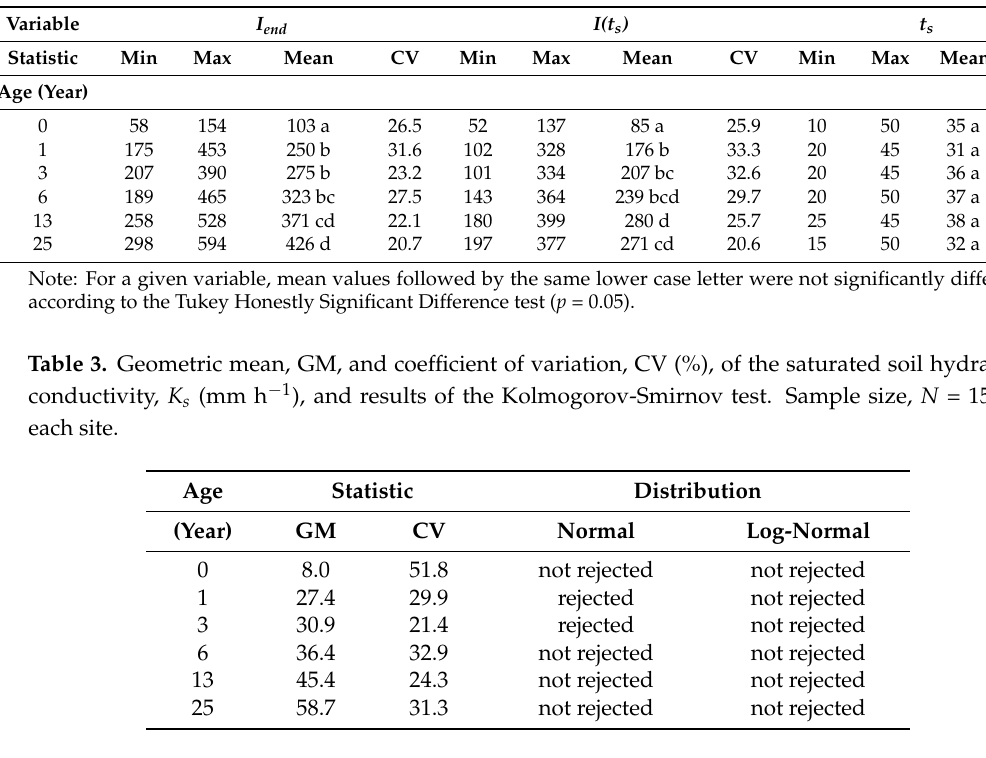
Table 2. Minimum, Min, maximum, Max, mean, and coefficient of variation, CV (%), of the total infiltrated depth, I end (mm), infiltrated depth at the equilibration time, I(t s ) (mm), and equilibration time, t s (min) ( N = 15 for each site).